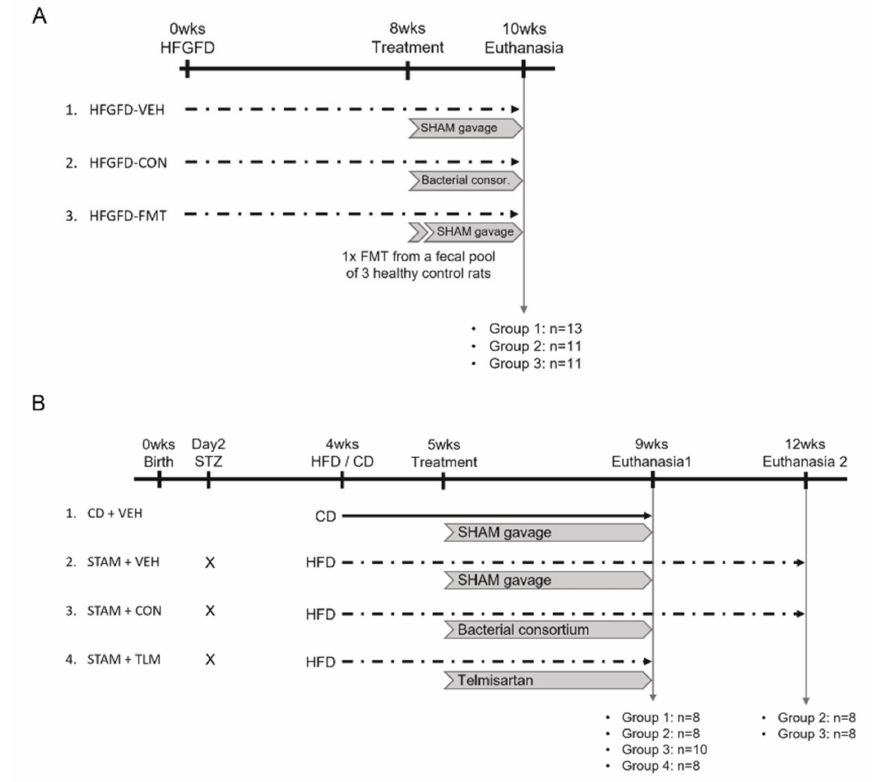
Figure 1. Experimental design. ( A ) Rat NASH model of PHT. Rats were fed a high-fat, high- glucose/fructose diet (HFGFD) for 8 weeks, after which they received either sham or bacterial consortium treatment for 2 additional weeks. HFGFD-VEH: group of NASH rats receiving sham gavage (vehicle); HFGFD-CON: group of NASH rats receiving the 9-strain bacterial consortium daily (2 × 10 9 CFU/d, total counts); HFGFD-FMT: group of NASH rats receiving fecal microbiota transplantation from control lean rats (1 × transplantation followed by sham gavage). ( B ) STAM™ mouse study. C57BL/6J male mice were subcutaneously injected with 200 µ g STZ, a β -cell toxin, two days after birth. At 4 weeks of age animals received a high-fat diet (HFD) or regular control diet (CD). At 5 weeks of age treatment was initiated: control diet animals and STAM mice received sham gavage (CD + VEH and STAM + VEH, respectively) for a total of 4 weeks. In the two test groups, STAM animals received either the 9-strain consortium (10 9 CFU/d, total counts) (STAM + CON) or Telmisartan (10 mg/kg/d) (STAM + TLM) also for a total of 4 weeks. At 9 weeks of age, the animals were sacrificed (euthanasia 1). Two groups of STAM animals belonging to the vehicle control or the consortium groups were followed for an additional three weeks until sacrifice at 12 weeks of age (euthanasia